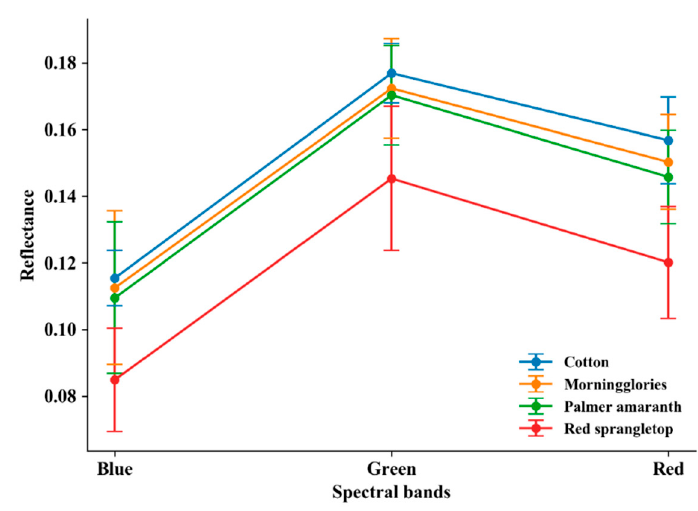
Figure 3. Reflectance values for the three most dominant weed species in the experimental area, compared with cotton for red, green, and blue bands in the visual imagery.